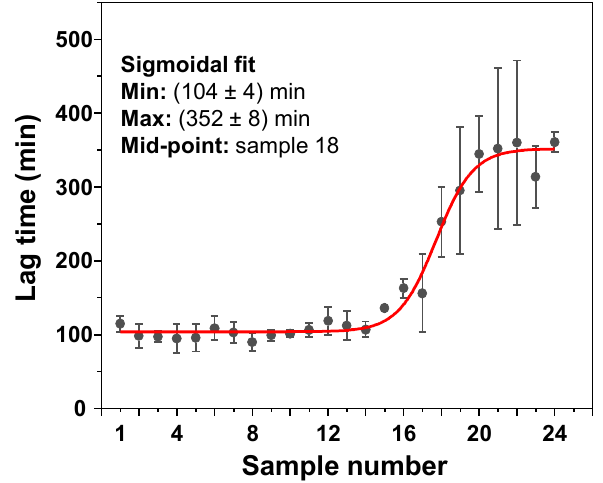
Figure A4. Insulin aggregation lag times when in the presence of a range of EGCG samples. Insulin aggregation was carried out in a 100 mM sodium phosphate (pH 2.4) buffer solution, containing 100 mM NaCl. All other reaction parameters were identical to AC conditions, as described in the Mate- rials and Methods section.